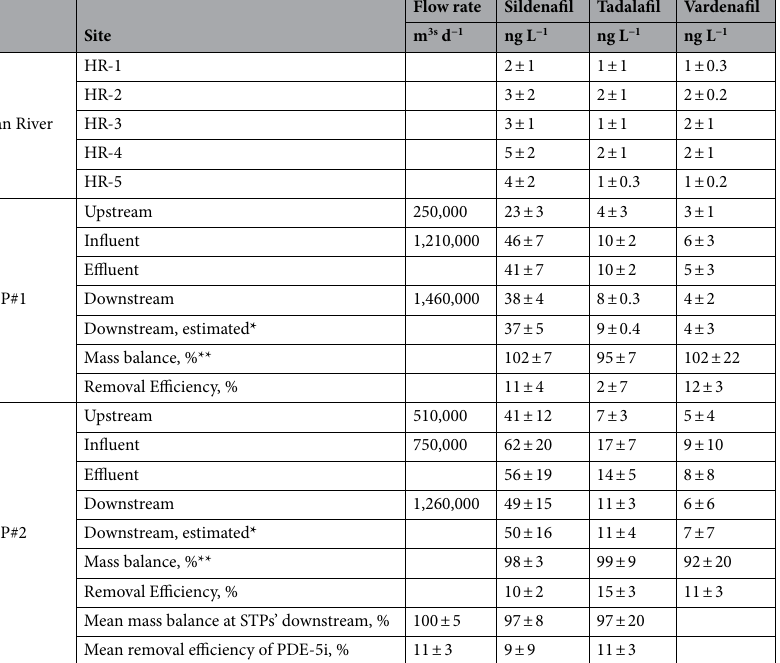
Table 1. Concentration, mass balance, and removal efficiency of three PDE-5i measured in the Han River and its tributaries including the two STPs. * In order to confirm that the contribution of PDE-5i at the tributary was due to the discharge from the STP, the estimation was performed by reflect the flow rate at each sampling point. **Measured using Eq.